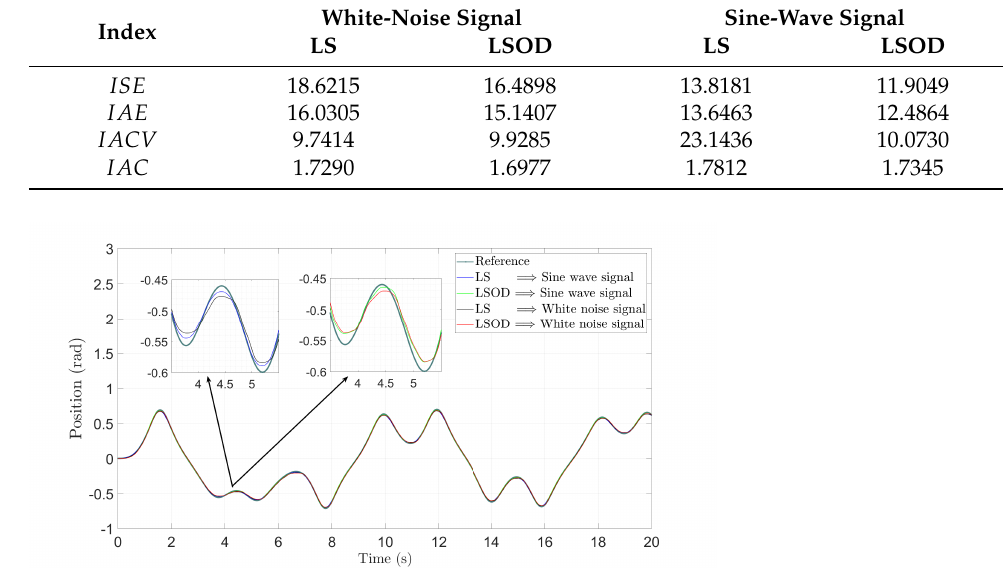
Figure 5. Reference and servo system angular positions produced by control law (60) with parameter estimates β ∗ , α ∗ and d ∗ 0 1